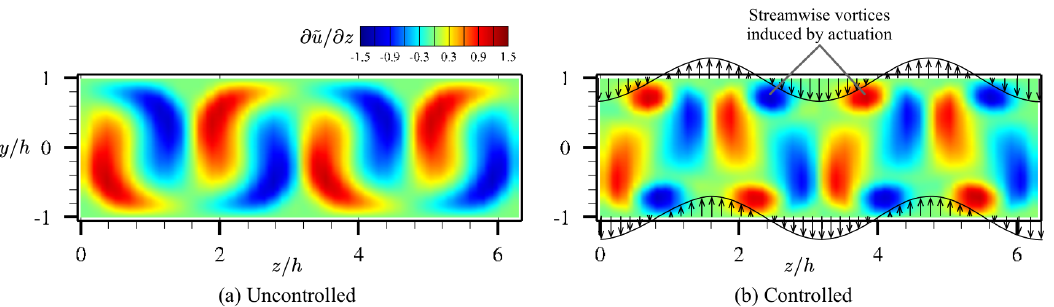
Figure 18. Modification of instantaneous streamwise velocity gradient in spanwise direction ∂ ˜ u / ∂ z at slice x / h = 0 and t ¯ u c / h = 50 in ( a ) uncontrolled flow compared to ( b ) controlled flow: Actuation velocity is denoted by black arrows.